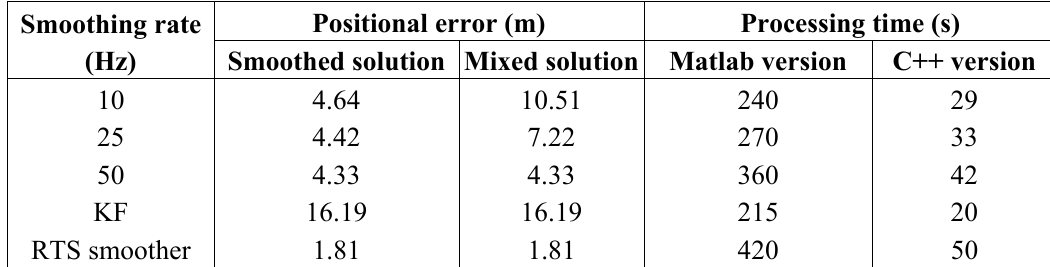
Table 6. Relationship between smoothing rate and positional error and processing time. Smoothing rate Positional error (m) Smoothed solution Mixed solution